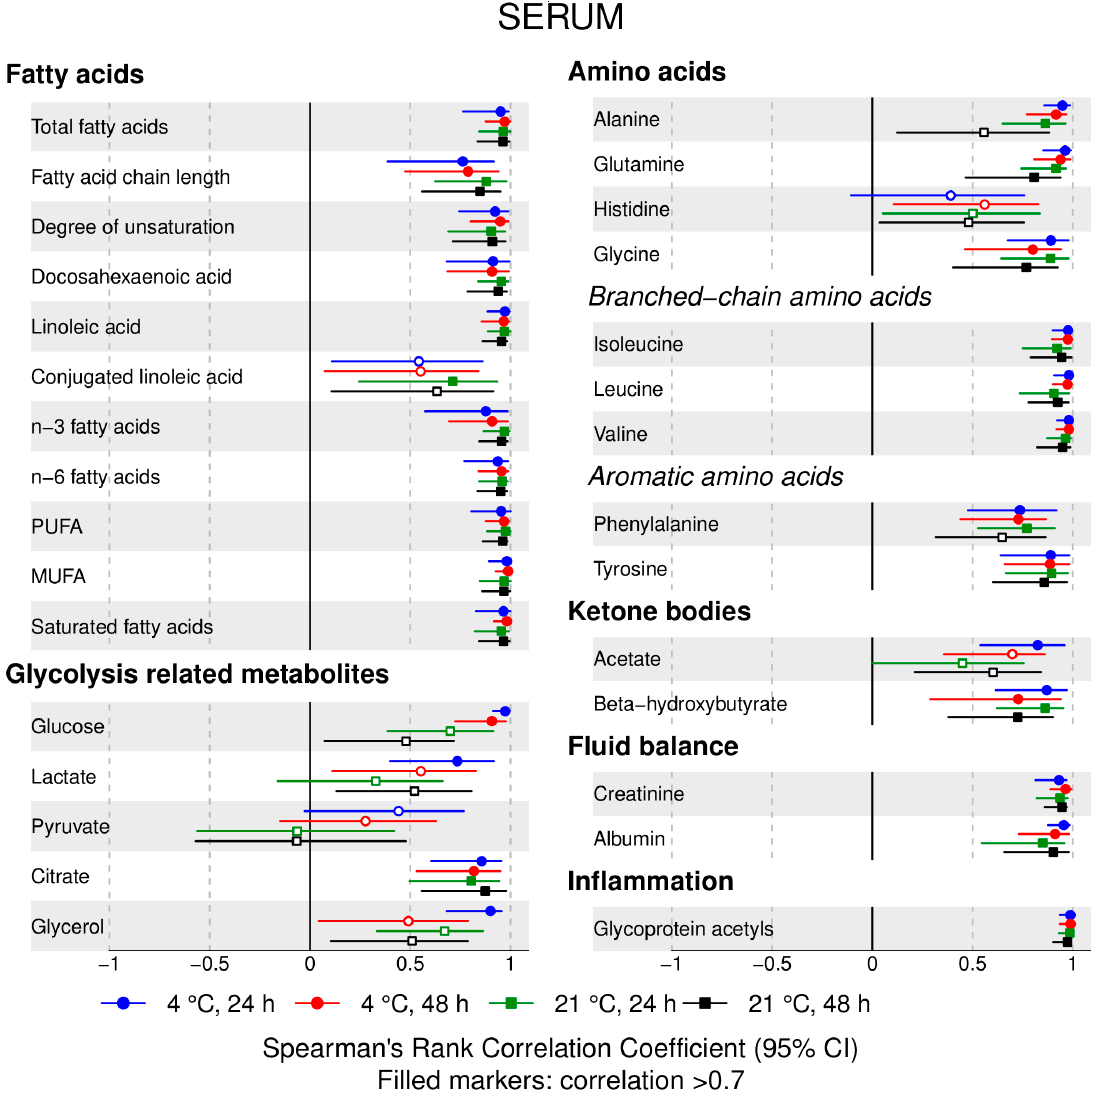
Figure 2. Serum, pre-storage handling effects (Figure 1 continued): Spearman’s rank correlation coefficients between metabolic trait concentration/value in reference samples (4 °C, 1.5 h) and samples incubated at (i) 4 °C, 24 h; (ii) 4 °C, 48 h; (iii) 21 °C, 24 h; and (iv) 21 °C, 48 h, before centrifugation (correlations for lipoprotein trait details are given in Figure S1, Supplementary Materials). Spearman’s rank correlation coefficients and 95% confidence intervals (CIs) are listed in Table S2, Supplementary Materials. MUFA, monounsaturated fatty acids; PUFA, polyunsaturated fatty acids.